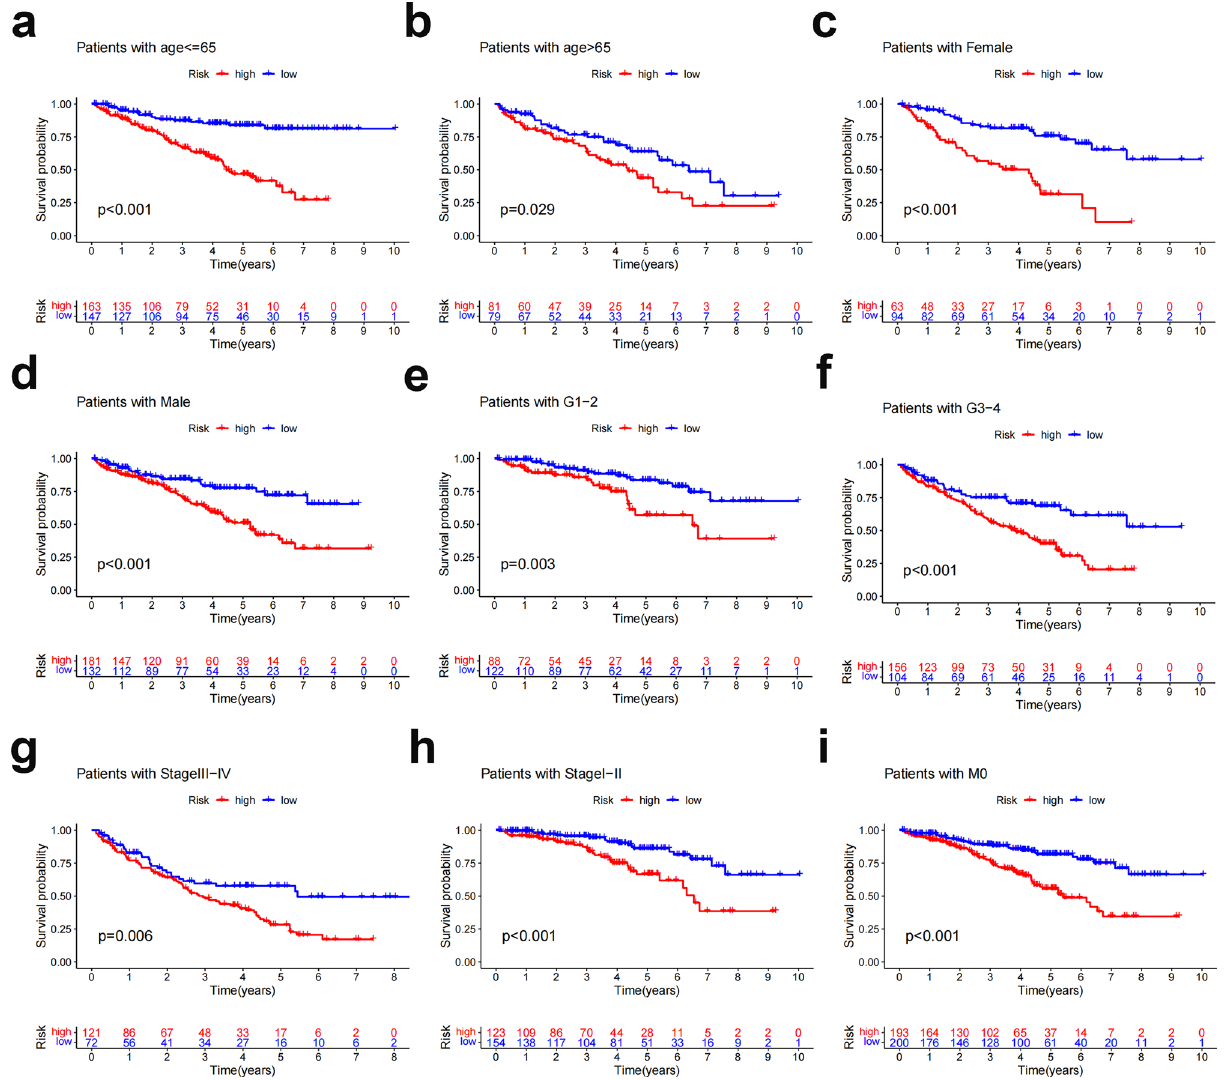
Figure 8. Kaplan ‒ Meier survival curves for high- and low-risk patients based on clinicopathological factors. ( a , b ) Age. ( c , d ) Sex. ( e , f ) Grading. ( g , h ) Staging. ( i ) M staging. M, distant